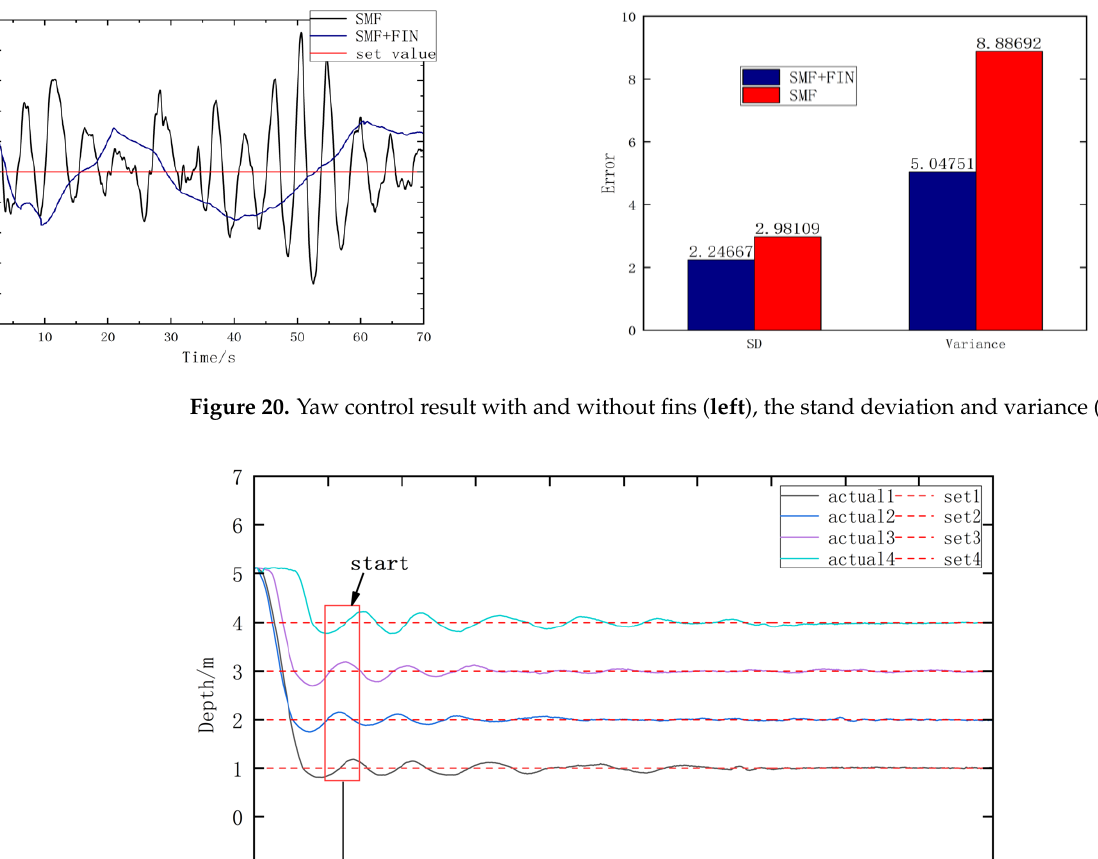
Figure 19. Attitude control result in hovering mode.